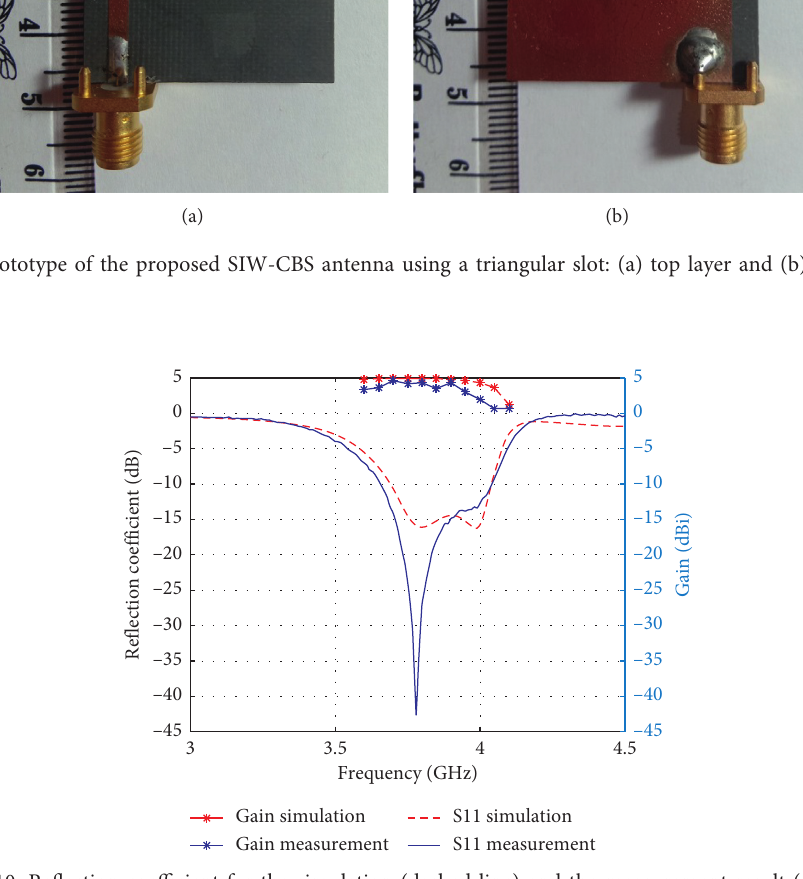
Figure 10: Reflection coefficient for the simulation (dashed line) and the measurement result (solid line).